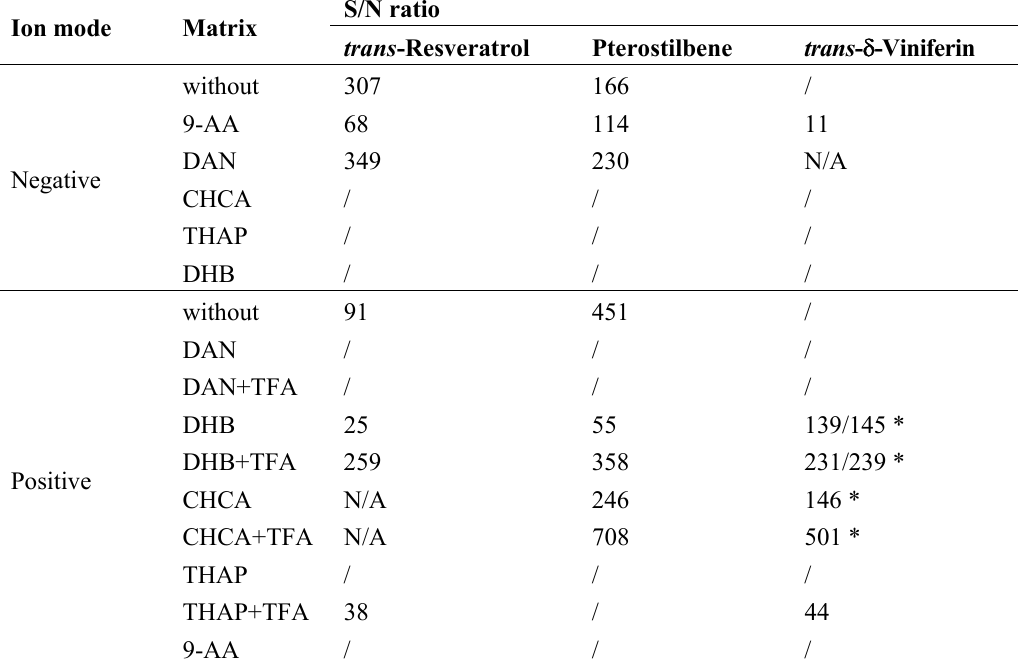
Table 1. Signal-to-noise ratio (S/N) values of Matrix Assisted Laser Desorption/Ionisation (MALDI)-time-of-flight mass spectrometer (TOFMS) peaks corresponding to stilbene molecular ions (* radical ion, otherwise, each peak corresponds to protonated ion (positive mode) or deprotonated ion (negative mode); N/A, not applicable because of the presence of an interfering